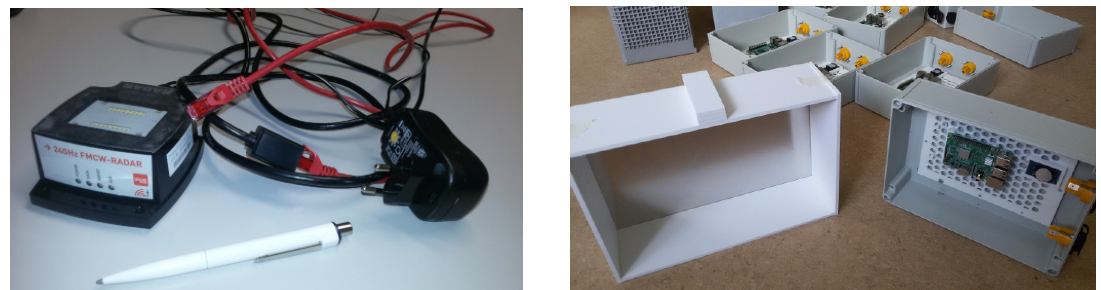
Figure 5. ( left ) a radar device; ( right ) constructing light traps (work in progress).